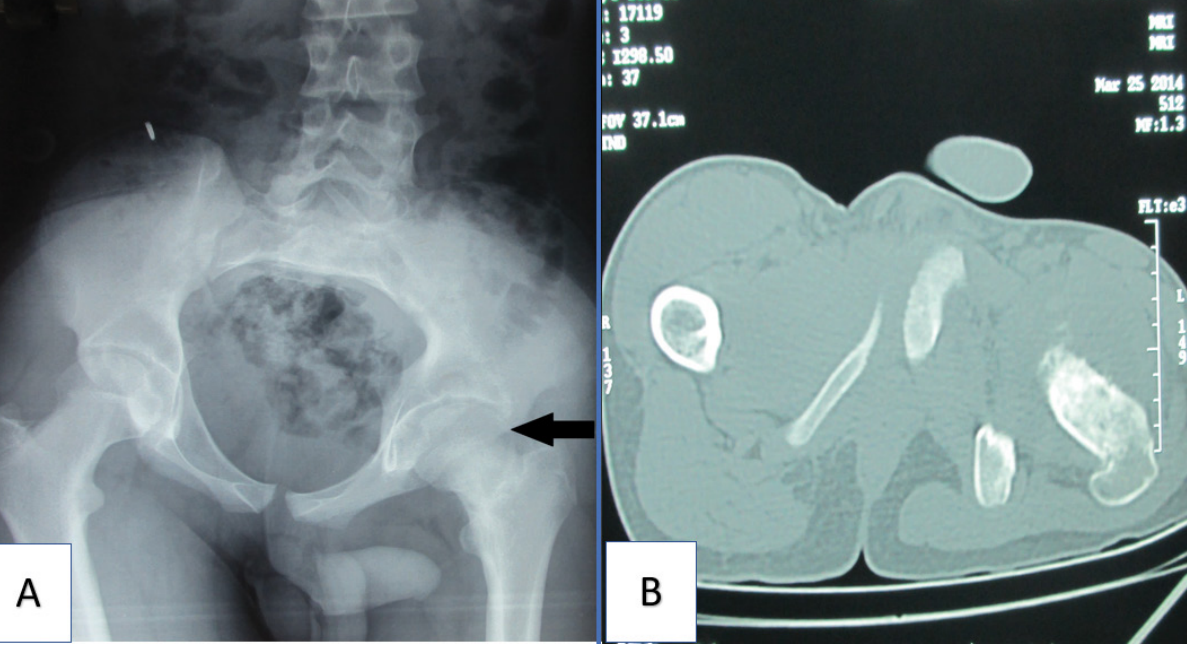
Figure 1A: Radiograph of hip joint shows mixed lytic and sclerotic lesion involving the femoral head and neck. Figure 1B: CT scan shows mixed lytic and sclerotic lesion involving the femoral head and neck with cortical irregularity and mild periosteal reaction with associated soft tissue in anterior aspect. No calcification and ossification were seen.